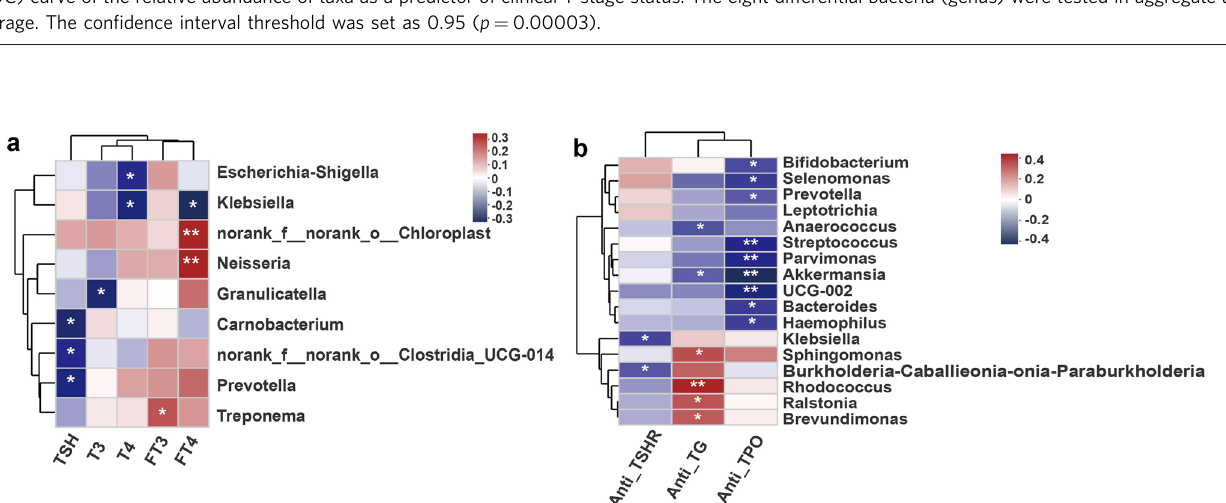
Fig. 2 Tumor microbiome communities signi fi cantly differ among clinical stages. a – c Bar plots of the genus level in patients with PTC. a Relative abundance for all patients with PTC. The genus level shows a more re fi ned taxonomic level than the phylum level in bacteria and can help fi nd particular species. b Relative abundance for patients with PTC in groups T1_2 and T3_4. c Relative abundance for patients with PTC in clinical stages T1 – T4. d and e Distribution of microbial communities in each group at the genus level. d Distribution of microbial communities for patients with PTC in groups T1_2 and T3_4. e Distribution of microbial communities for patients with PTC at clinical stages T1 – T4. The data are visualized using Circos. The width of the bars for each genus indicates the relative abundance of that genus in the group. f Microbiome alterations at the genus level in patients with PTC of clinical stages T1 – T4. Intragroup differences were analyzed using the Kruskal – Wallis test, and differences between groups were analyzed based on the post-hoc test using Welch ’ s uncorrected test, adjusted by false discovery rate. The top three differential bacteria (genus) identi fi ed were tested individually. g Taxonomic cladogram from LEfSe, depicting taxonomic associations between microbiome communities from patients with T1_2 and T3_4 PTC. Each node represents a speci fi c taxonomic type. Yellow nodes denote taxonomic features that are not signi fi cantly differentiated between T1_2 and T3_4. Red nodes denote taxonomic types more abundant in T1_2 than in T3_4, whereas blue nodes represent taxonomic types more abundant in T3_4. h LDA score computed from differentially abundant features between T1_2 and T3_4. The criterion for feature selection was log(LDA score) >3.2. i Receiver operating characteristic (ROC) curve of the relative abundance of taxa as a predictor of clinical T stage status. The eight differential bacteria (genus) were tested in aggregate as average. The con fi dence interval threshold was set as 0.95 ( p = 0.00003).